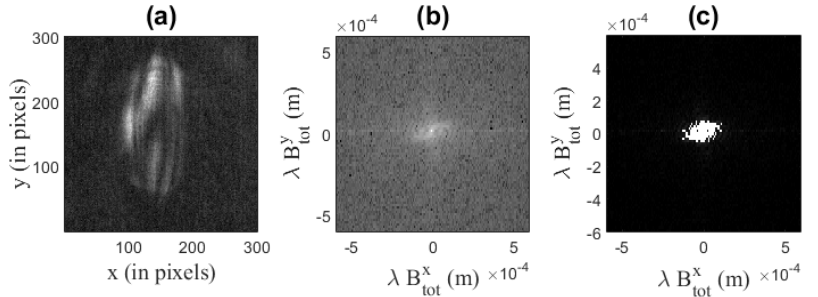
Figure 9. Section of the interferometric image of particle 1 (in red in Figure 7) that will be 2D Fourier-transformed ( a ), the log of its 2D Fourier transform ( b ), and its binarization ( c ). Table 1. Parameters deduced during the analysis of the 4 “encircled” particles of Figure 7.